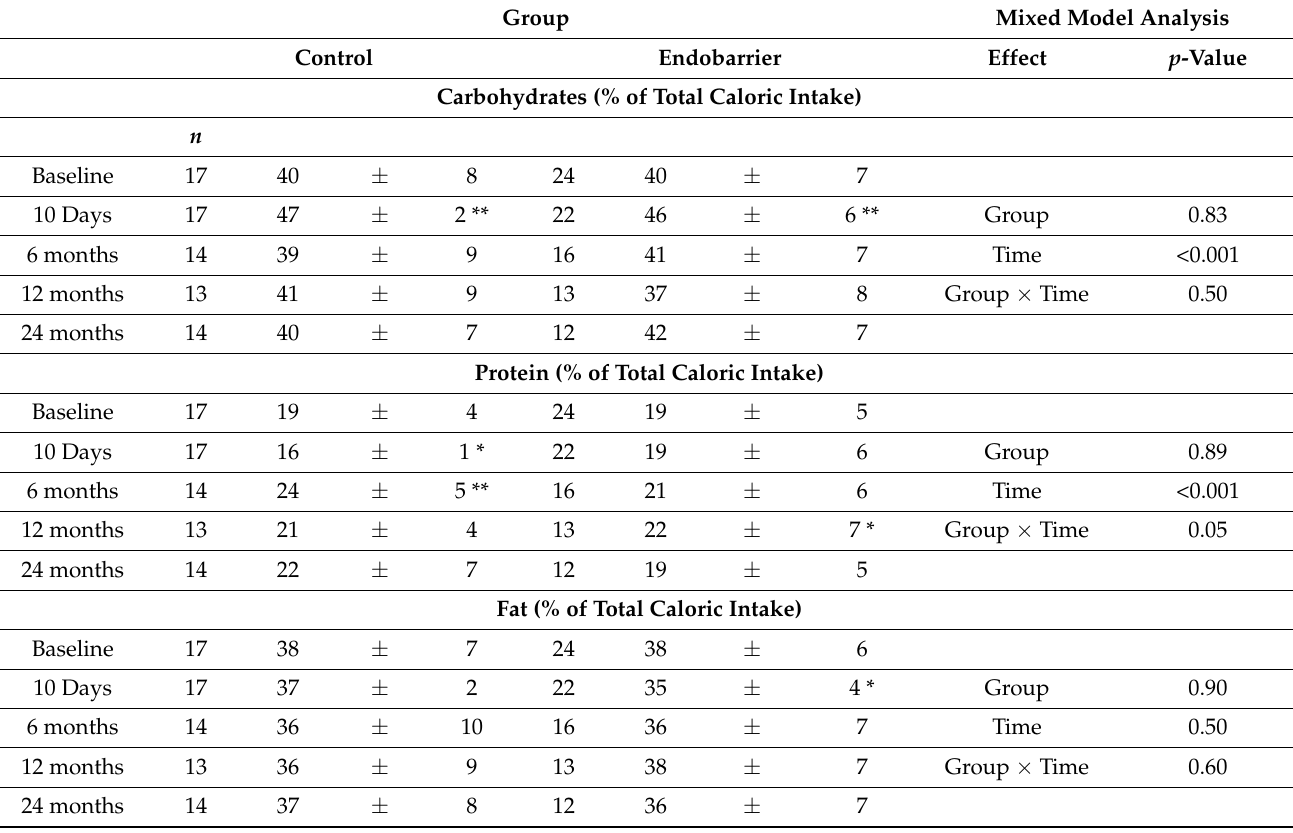
Table 3. Percentage contribution of macronutrient to daily energy